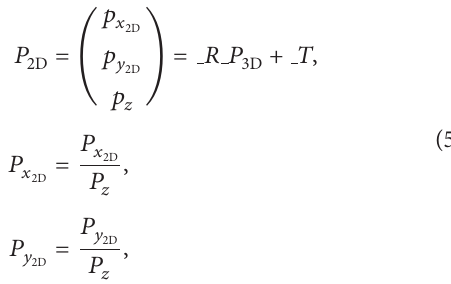
Table 2: Calibration parameter values of the Kinect sensor used in this work. 𝑓 𝑥 ,𝑓 𝑦 and 𝑓 𝑥𝑑 ,𝑓 𝑦𝑑 are the focal lengths in 𝑥 and 𝑦 (to accommodate astigmatism of the lens systems) of the colour cameraanddepthsensor,respectively. 𝑝 1 and 𝑝 2 areradialdistortion parameters, while 𝑘 1 , 𝑘 2 ,and 𝑘 3 aretangential distortionparameters. 𝑓 5.2922 × 10 𝑥 =